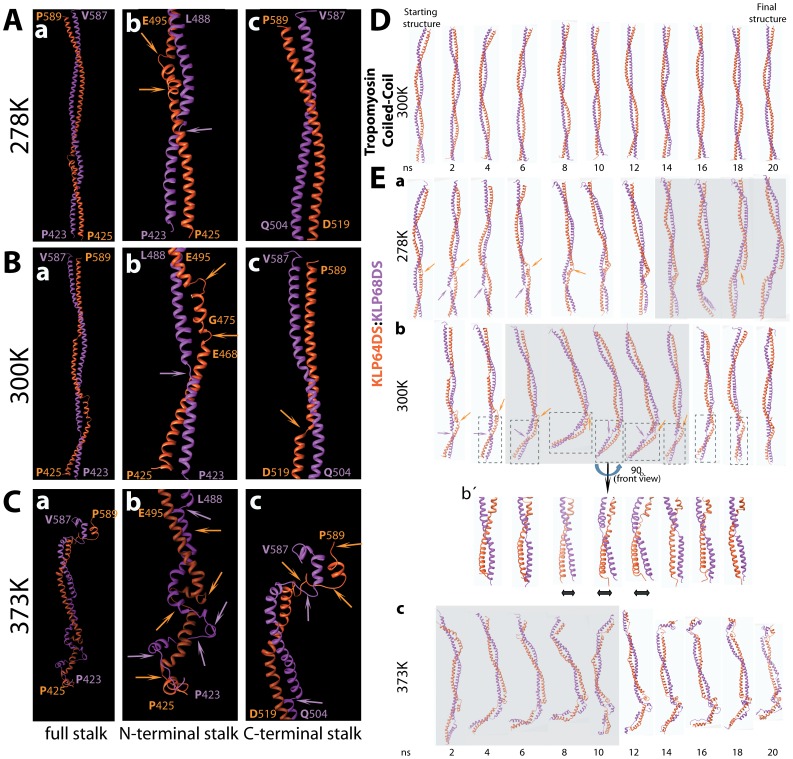
Interactions between the C-terminal regions of the KLP64D and KLP68D-Stalk polypeptides play a critical role in maintaining the heterodimer.A–C) Snapshots of KLP64D/68D-S heterodimer after 20 ns of MD simulations at 278K (A), 300K (B) and 373K (C), respectively. Ribbon structures of the full length stalk heterodimer (a), the N-terminal segments (P425–L506 of KLP64D and P423–I501 of KLP68D) (b), and the C-terminal segments (R517–P589 of KLP64D and T511–V587 of KLP68D) (c), respectively, are depicted in separate panels. Arrows indicate the unstructured regions in between the α-helices in KLP64D (orange arrow) and the KLP68D (magenta arrow) chains. D) Snapshots of the evolution of the tropomyosin coiled-coil structure during the MD simulations at 300 K. E) Snapshots of the evolution of the KLP64D/68D-Scoiled coil model at 278 K (a), 300 K (b and b´), and 373 K (c), respectively. The boxed region highlights dynamic fold-back of the N-terminal KLP64D/68D-Stalk at 300 K. An enlarged view of the N-terminal portion is shown in (b´) after a 90° rotation of the viewing angle. Arrows indicate the unstructured fragments present in between the α-helices in KLP64DS (orange arrow) and the KLP68DS (magenta arrow) chains. The shaded background box indicates simulation times when the stalk domain is in incomplete fold back configuration.